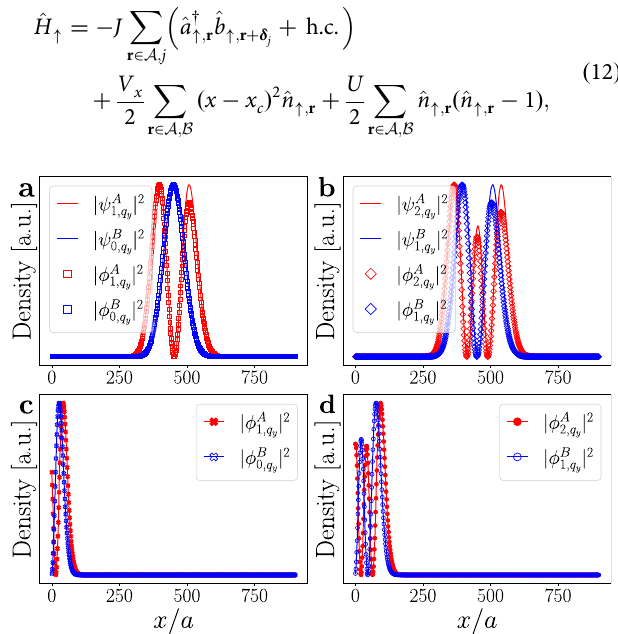
Fig. 3 Landau levels density distributions. Density corresponding to the eigenfunctions ϕ ν ; q of ^ H 0 for N x = 601 sites and strain strength τ = 0.003 y for various values of ( q y a , E ): ( a ) (0, 0.039), ( b ) (0, 0.055), ( c ) (0.206, 0.06), ( d ) (0.179,0.06), which are compared to the analytical Landau level eigenfunctions, ψ ν ; q , from Eq. (10), where ν is the number of y the Landau level. Their respective markers correspond to the ones in Fig. 2. While panels ( a ) and ( b ) show bulk eigenfunctions of the fi rst and second Landau levels, panel ( c ) and ( d ) show corresponding edge states localized at the left edge near x =